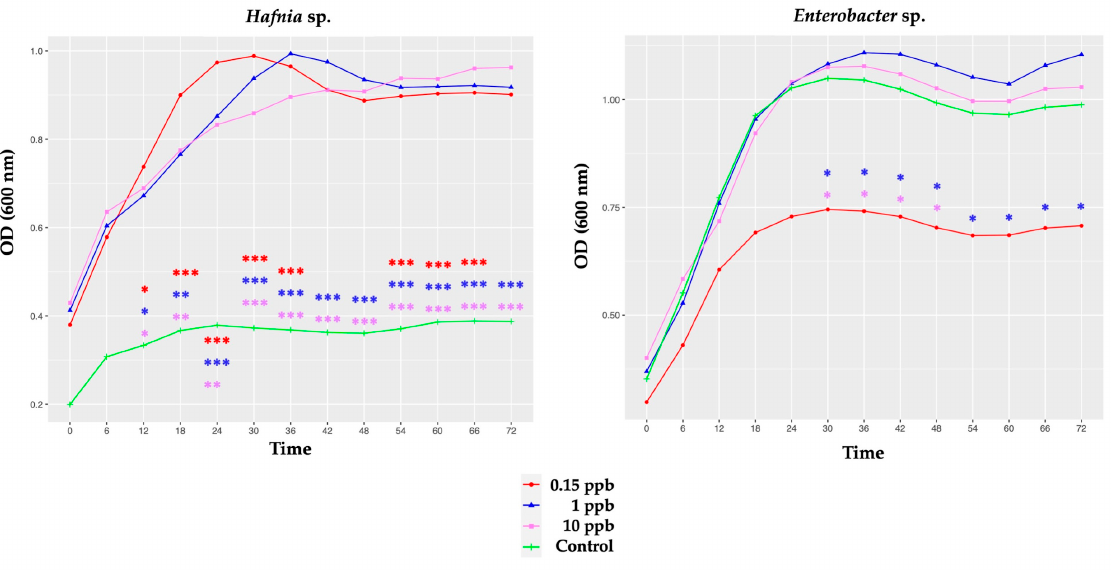
Figure 3. The bacterial growth curves represent the optical density (OD) units at 600 nm over time (hours) for Hafnia sp. and Enterobacter sp. cultured in TSB liquid media supplemented with 0 ppb (green curve) (unexposed group); 0.15 ppb (red curve); 1 ppb (blue curve) and 10 ppb (violet curve) for 72 h. Experiment was performed in triplicate. Each data point represents the average optical density (600 nm) measured every 6 h. Multiple comparisons using an ANOVA analysis were computed. p -values were adjusted with Tukey’s method.